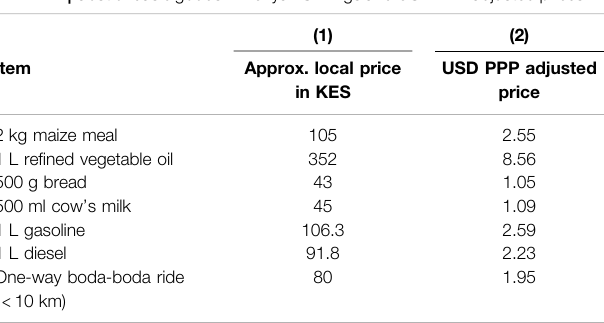
TABLE 1| Cost of basicgoods inKenyan Shillings and USD PPP adjusted